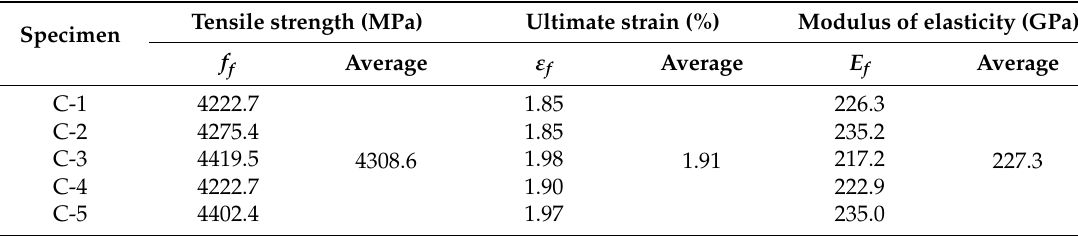
Table 3. Tensile test results of CFRP flat